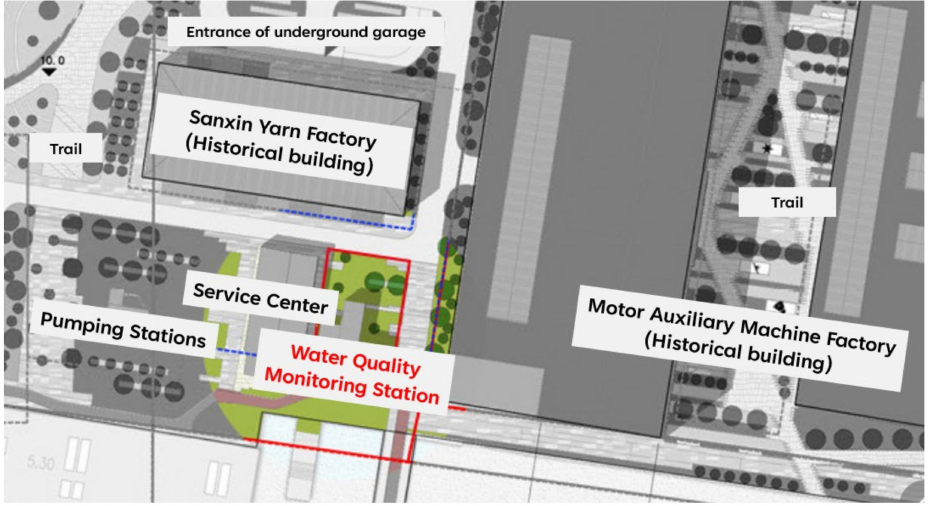
Figure 2. The geographical location of the water quality monitoring station.